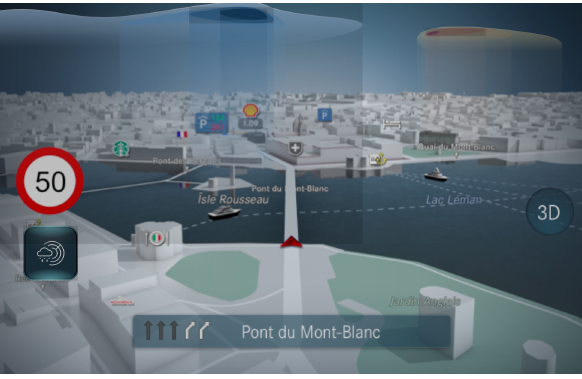
Figure 11. Design concept for rain map feature in